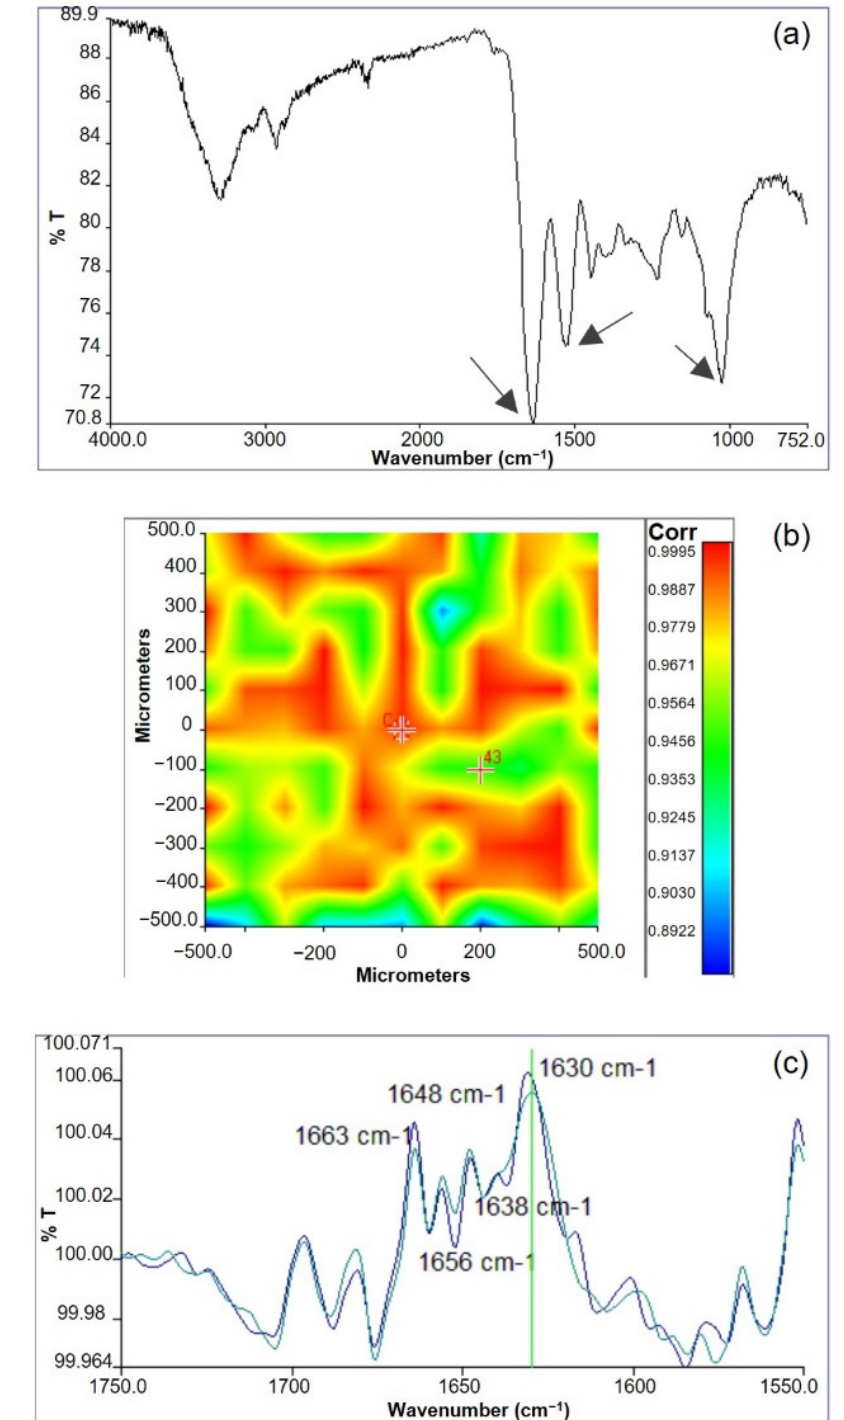
Figure 3. Infrared analysis of GGE scaffolds: ( a ) Medium spectrum recorded from the chemical map; ( b ) correlation map between the chemical map and the medium spectrum; ( c ) second derivative spectra.